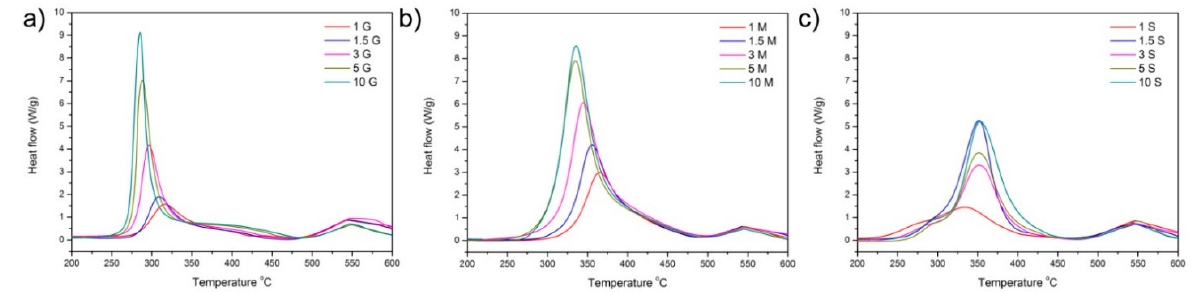
Figure 5. Differential thermal analysis curves of the materials functionalized with ( a ) GLYMO, ( b ) MEMO, and ( c ) MPTMS at different concentrations (indicated in the labeling as % weight).